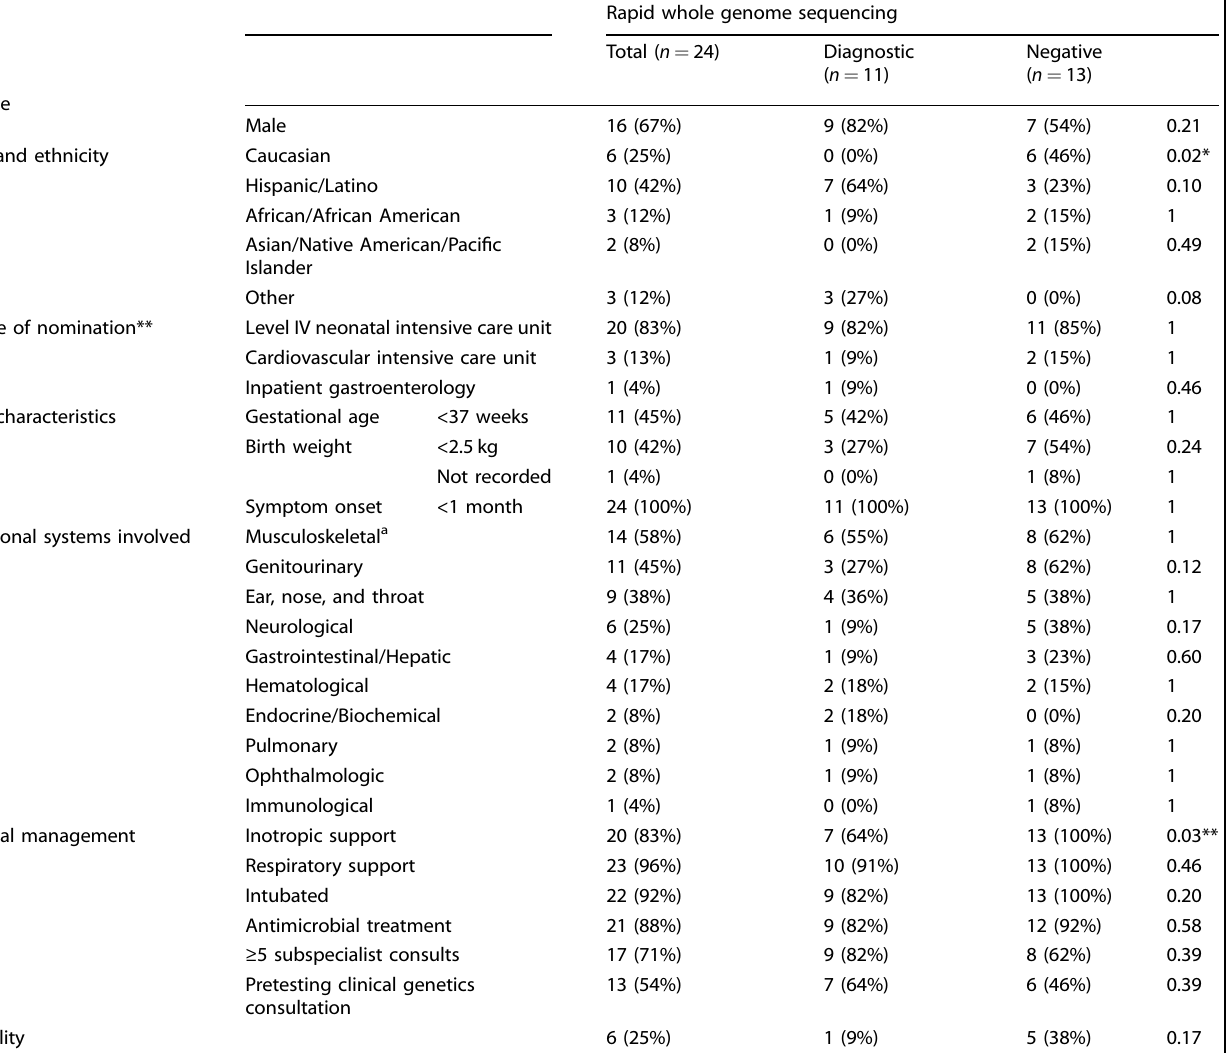
Table 1. Demographic and clinical characteristics of the